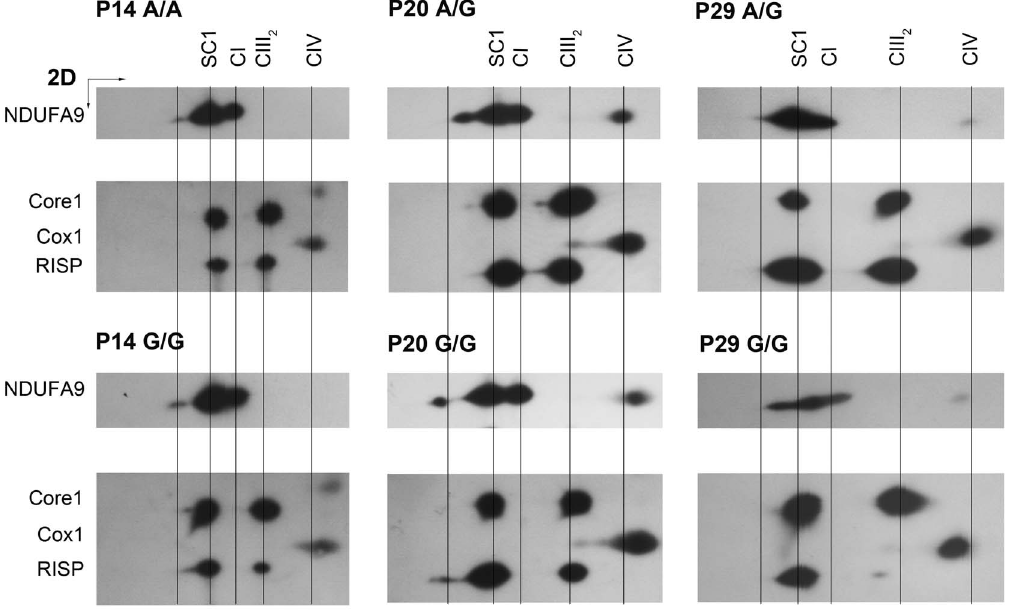
Figure 4. The main supercomplex contains CI, pre-CIII and fully assembled CIII 2 . Isolated liver mitochondria from P14, P20 and P29 Bcs1l G/G (G/G) and control (A/A and A/G) mice were analyzed with two-dimensional run with BNGE/SDS PAGE and Western blot. Antibodies for complexes are the same as in Figure 2 and 3. The ratio of RISP/Core1 was clearly smaller in P29 homozygotes than in control animals.